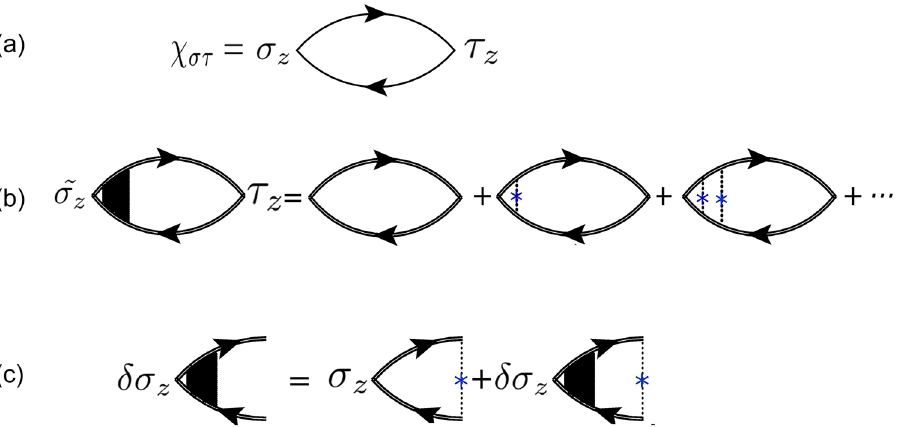
Figure 1. Feynman bubble diagrams; the graphical representation of spin to pseudo-spin response function. Single lines are undressed Green’s functions of the sample while double lines denote the dressed Green’s functions. Cross shape blue points refer to impurity and dashed lines show scattering from impurity potential 26 . ( a ) Unperturbed response function of the spin and pseudo-spin. ( b ) Ladder diagrams correspond to the corrections of the response function which come from successive interactions of electron-hole pair with impurities that leads to normalized vertex spin operator. ( c ) The diagrammatic approach of electron-hole pair interactions with impurities results in iterative equation of vertex